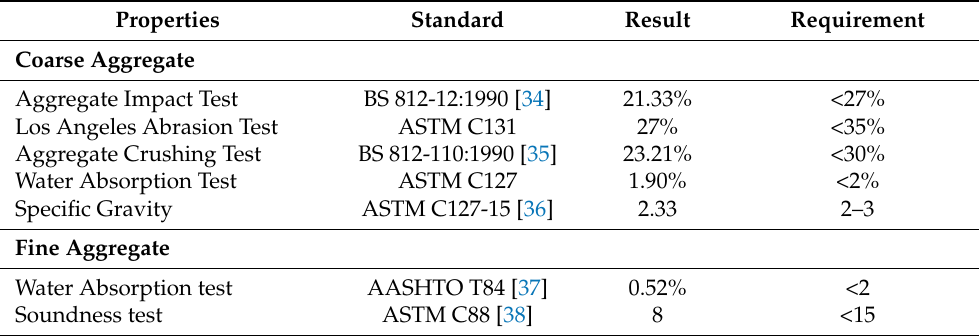
Table 2. Properties of aggregates